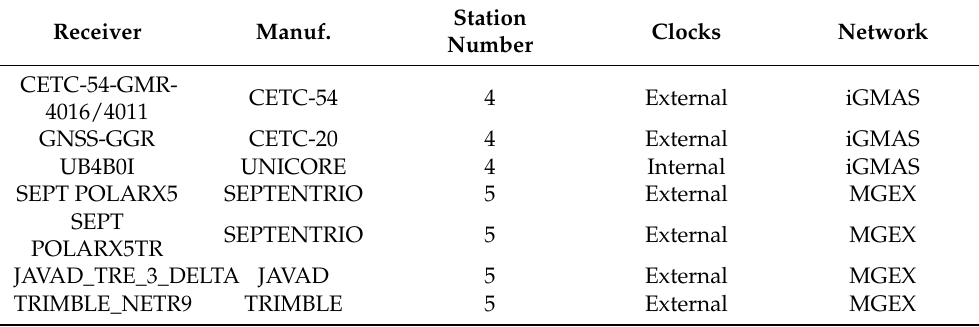
Table 2. Information of receivers.